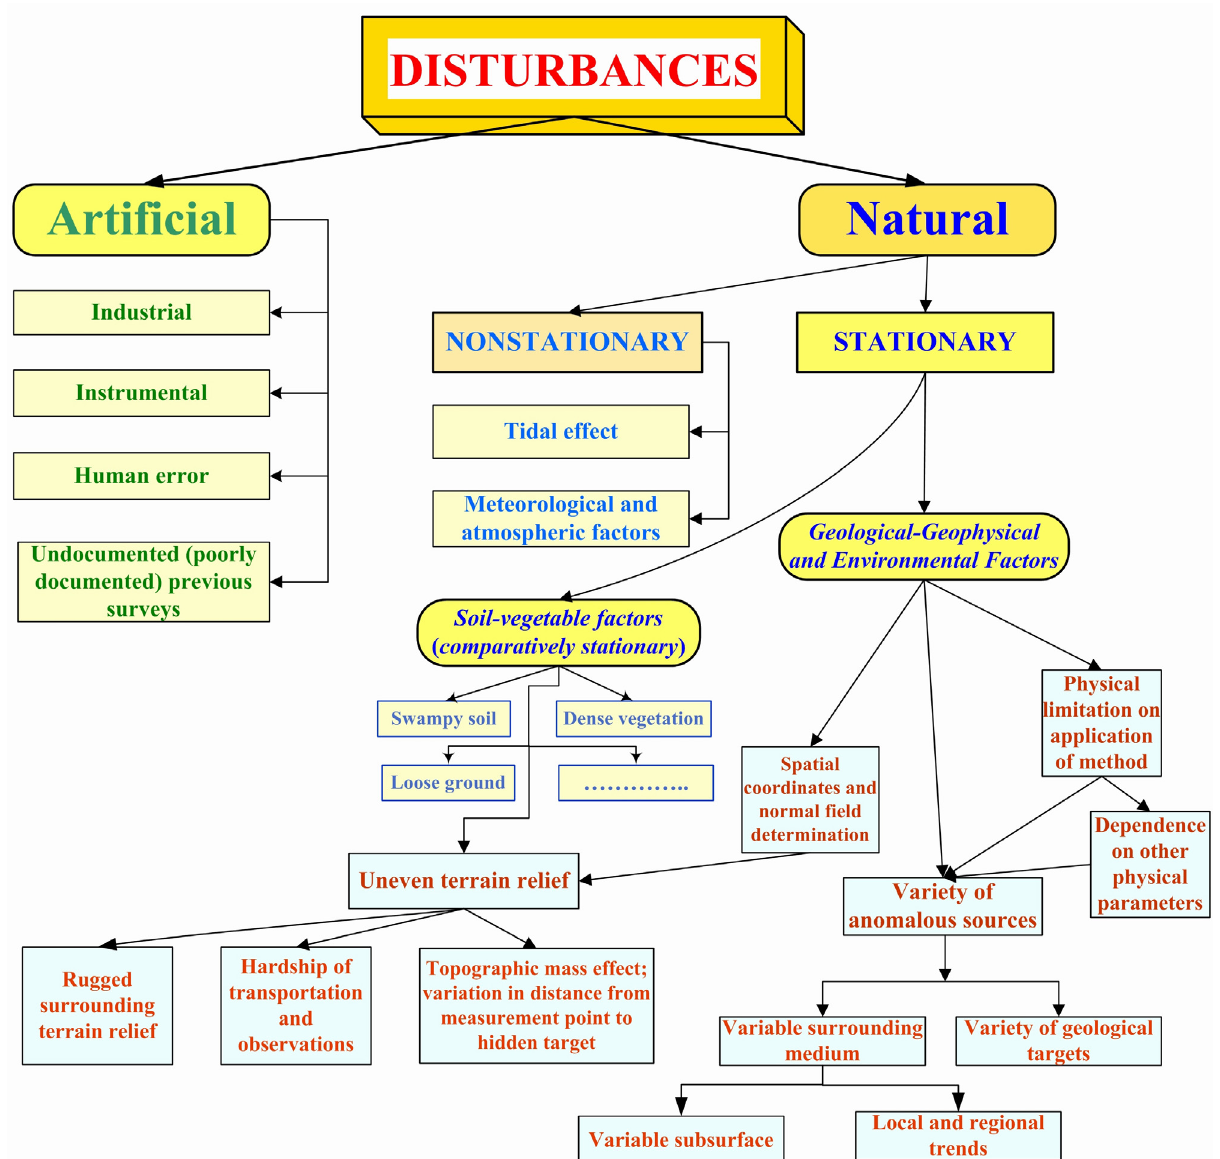
Figure 1. Noise affecting microgravity investigations (modified and enlarged after Eppelbaum,